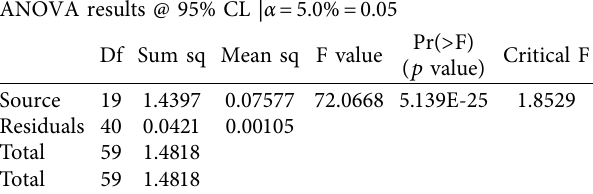
Figure 2: Boxplot analysis. Table 4: ANOVA